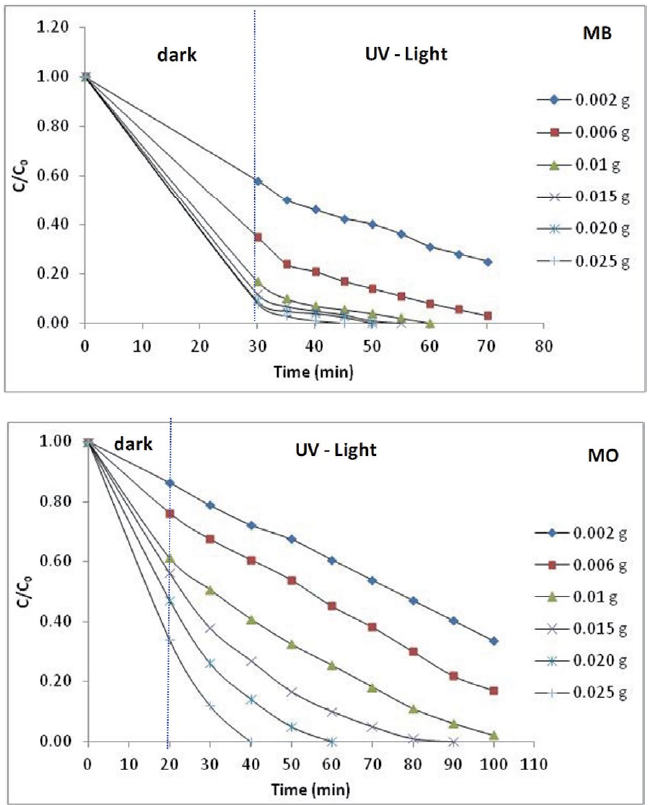
Fig. 4. Effect of catalyst dose on the photocatalytic degradation of dyes (C Fig. 4 ppm, Optimum pH values, T = 298